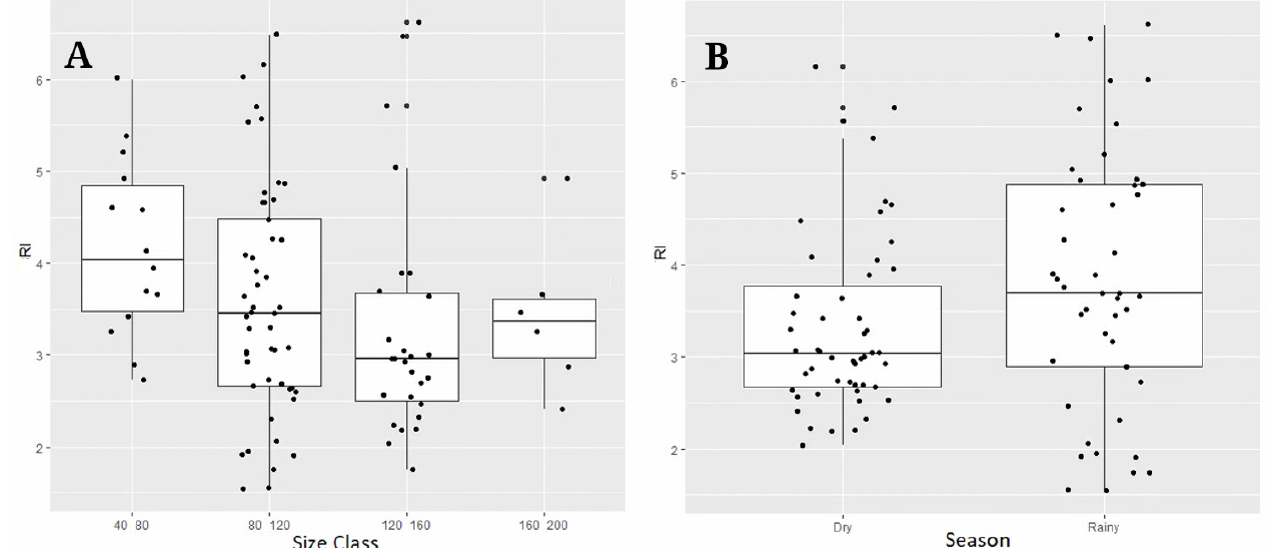
FIGURE 2 | Variation in Stomach Repletion Index (RI) values (black spots) of Electrophorus varii in Curiaú River EPA Amapá, Brazil. A. Size class; and B. Season. The lower and upper bars of the boxplot represent 25 and 75 quartiles, respectively. The horizontal bar within each boxplot represents the mean RI value. The lower and upper vertical line represent the RI values